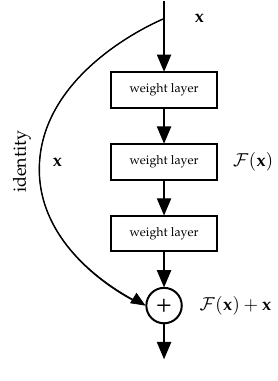
Figure 1. A residual building block. Instead of letting the layers learn the desired mapping H ( x ) , a skip connection (identity mapping) is constructed that forces the skipped layers to fit a residual mapping F ( x ) = H ( x ) − x , that is easier to optimize since the skipped layers are relieved of learning x